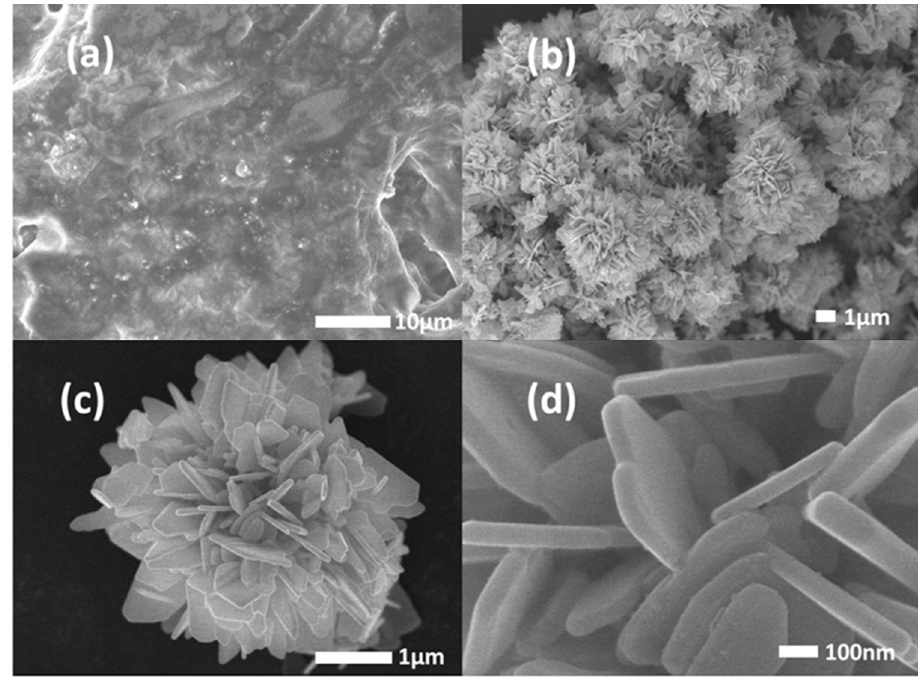
Figure 2. Representative SEM images of ( a ) the ZnO precursor before calcination; ( b – d ) the as-prepared lettuce-like ZnO.